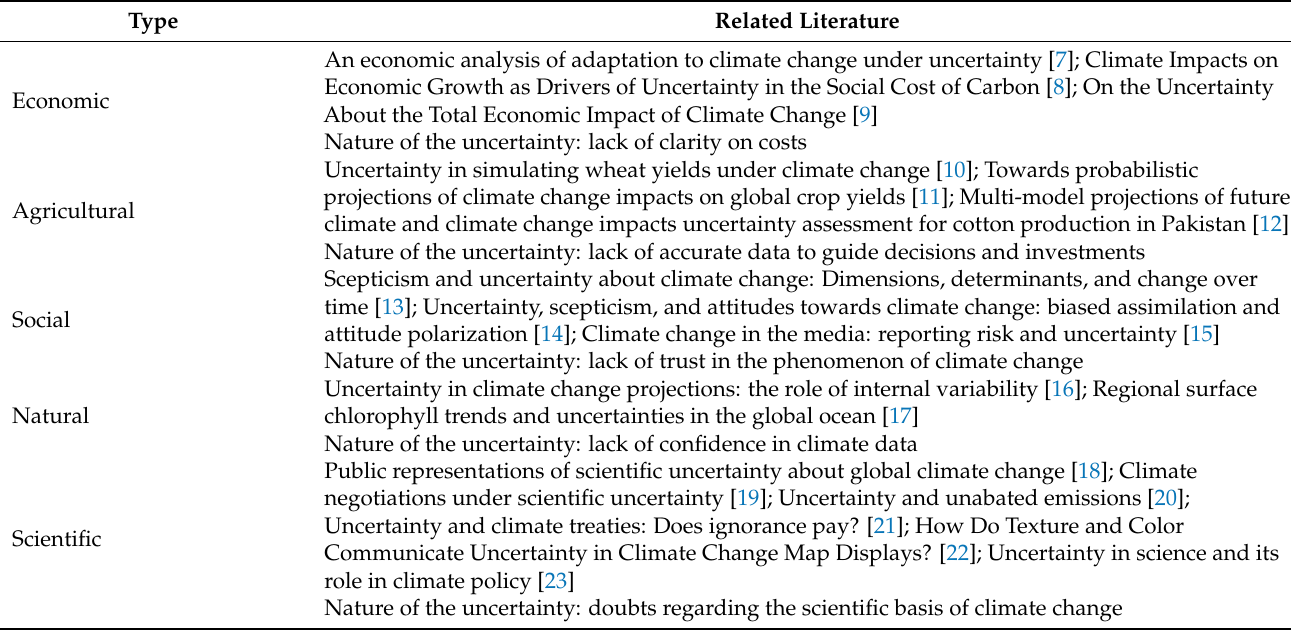
Table 1. Some types of